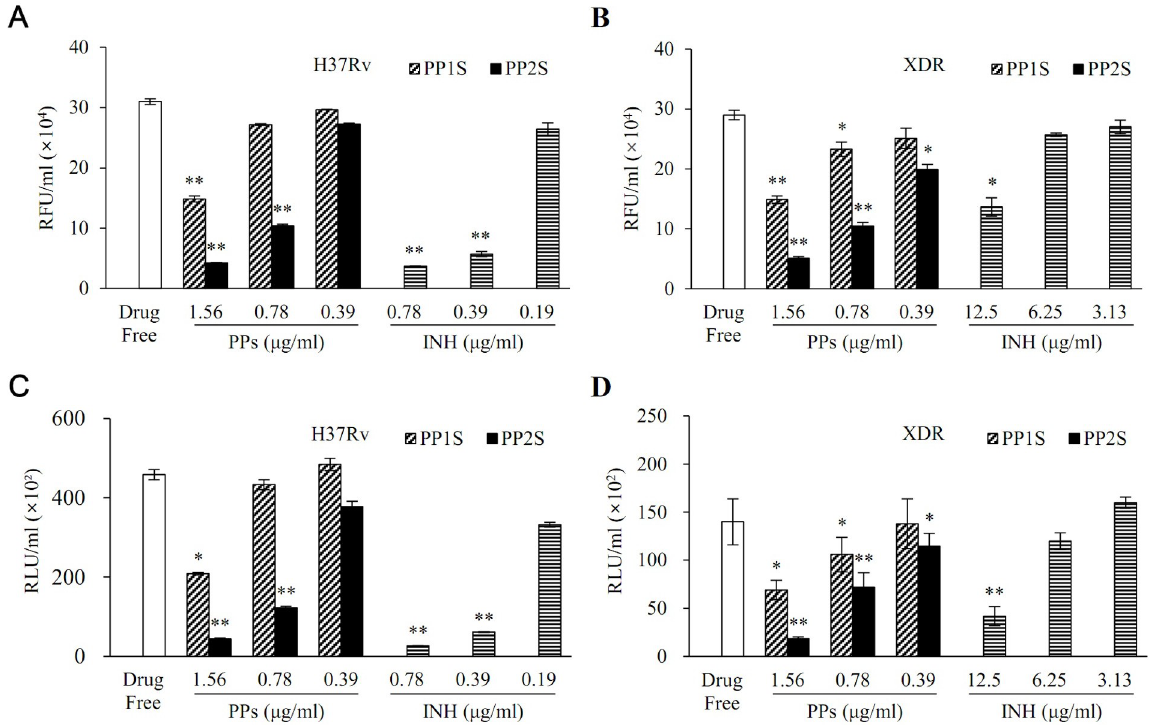
Fig 2. In vitro antitubercular activities of PPs against (A and C) M . tuberculosis H37Rv and (B and D) XDR M . tuberculosis measured by (A and B) fluorescence-based resazurin microtiter assay and (C and D) luminescence-based microbial cell viability assay. Experiments were performed in triplicate and repeated 3 times. Data are presented as mean ± SD and Student t test was used to compare groups ( � p < 0.05, �� p < 0.01). INH, isoniazid; PP, methyl (S)-1-((3-alkoxy-6,7-dimethoxyphenanthren-9-yl)methyl)-5-oxopyrrolidine-2-carboxylate; XDR, extensively drug- resistant. Data underlying this Figure can be found in S1